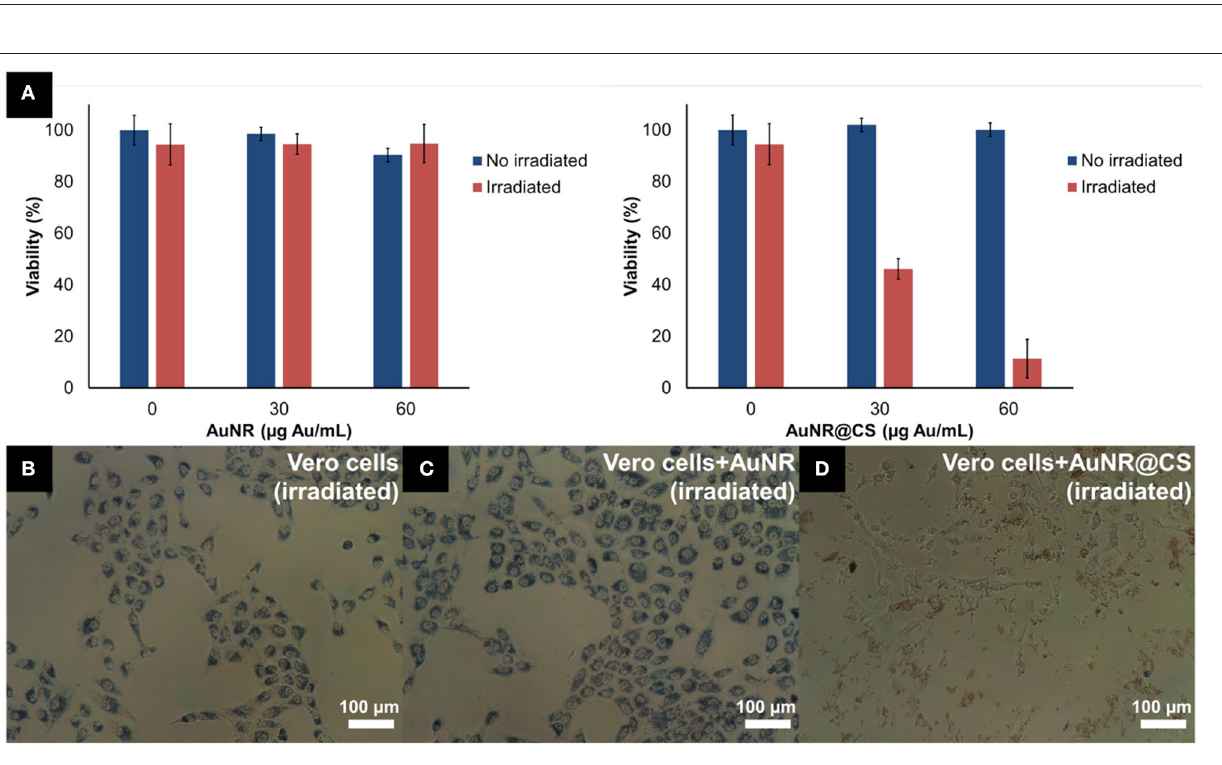
Frontiers in Chemistry | www.frontiersin.org